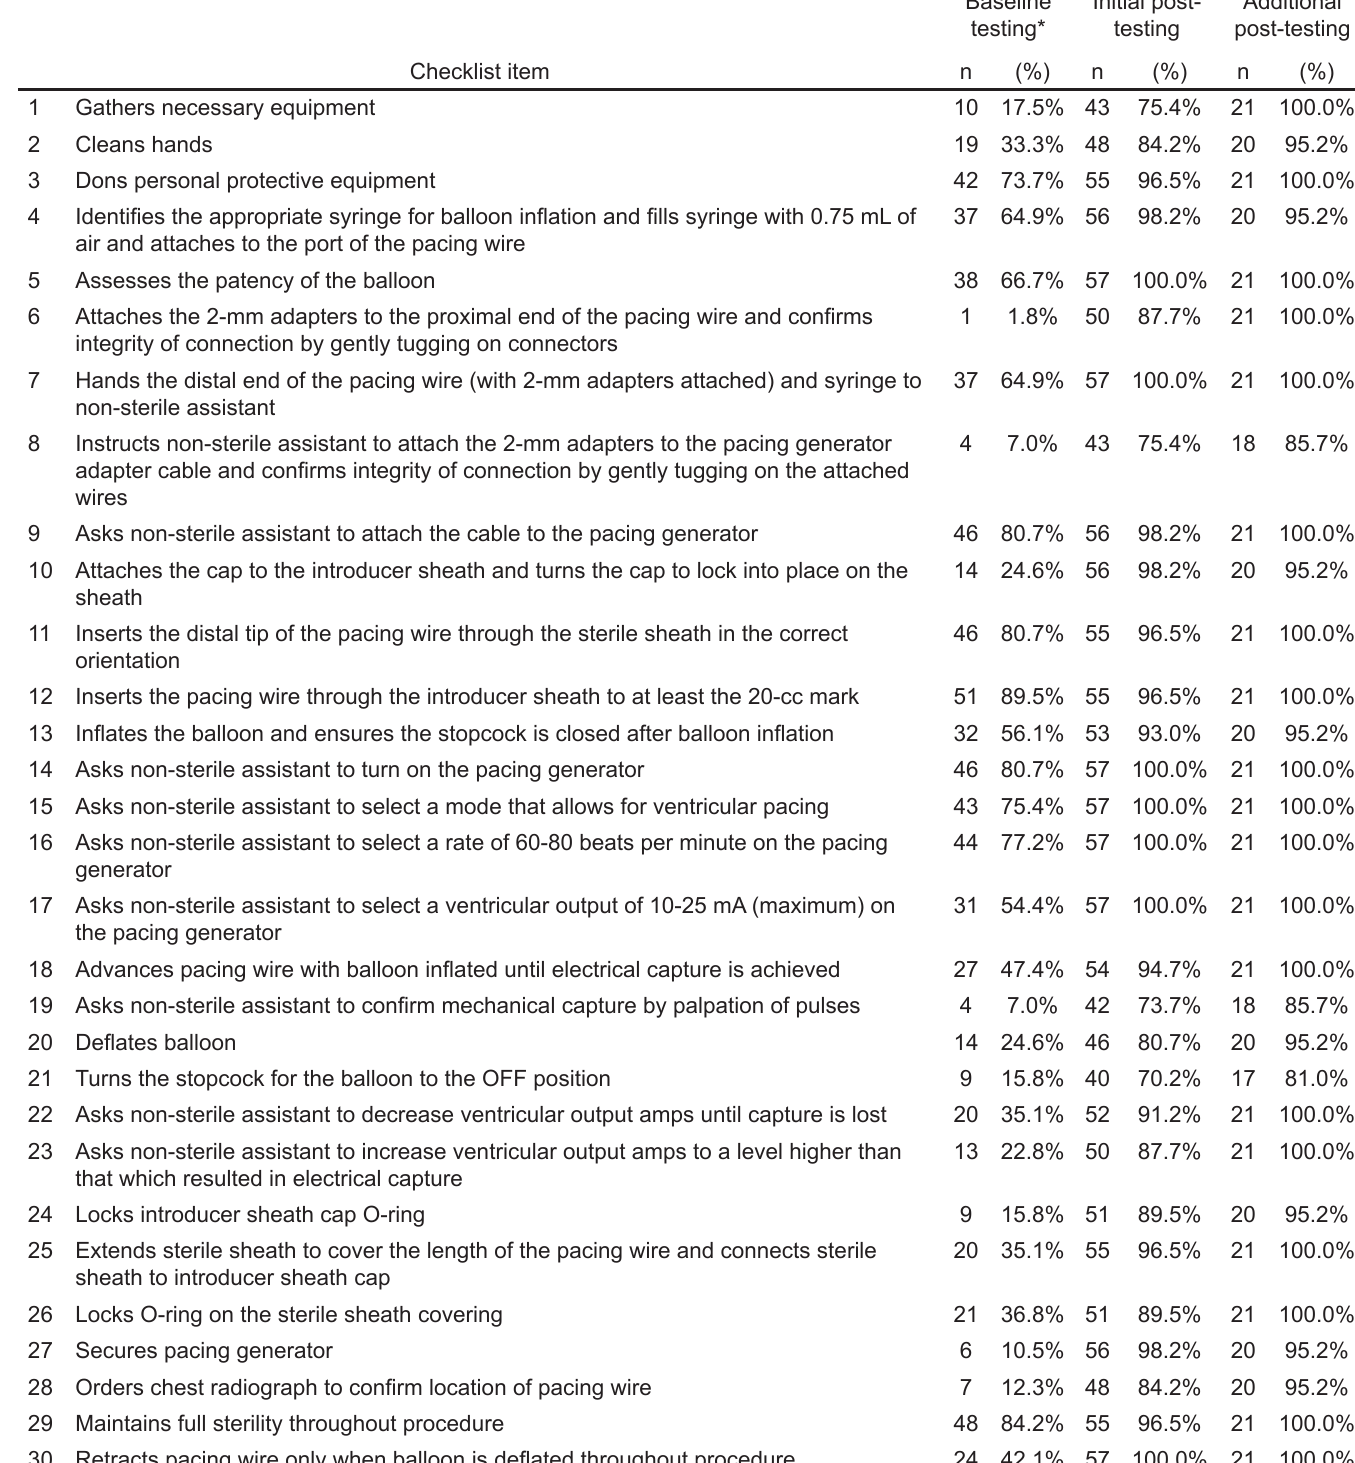
Table 2. Learner performance for individual checklist